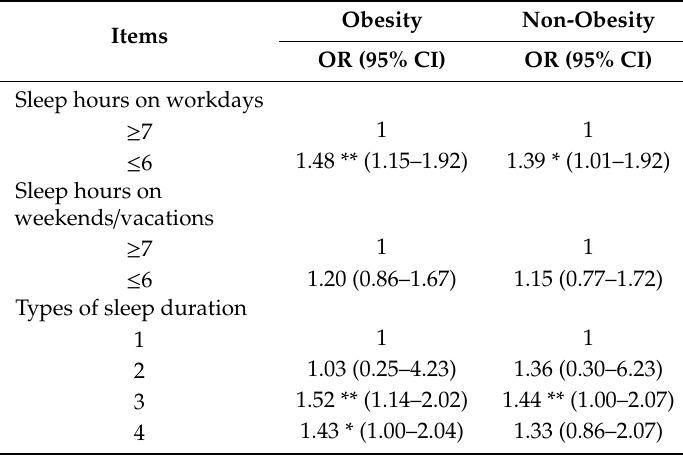
Table 4. Sleep hours on workdays and on weekends / vacations associated with T2DM using multiple logistic regression based on obesity adjusted for age, gender, education level, marital status, and smoking and alcohol consumption.